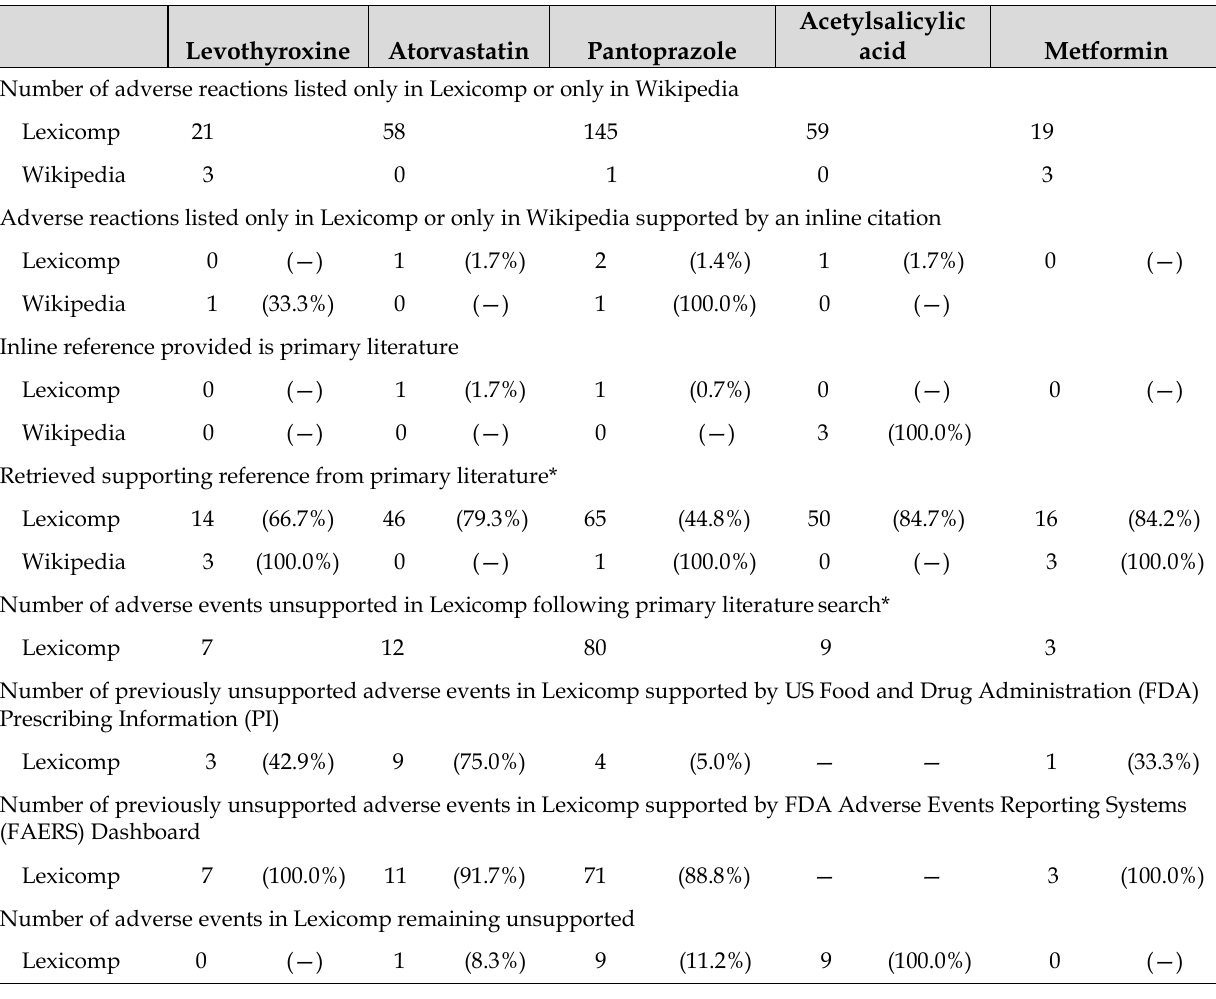
Acetylsalicylic acid